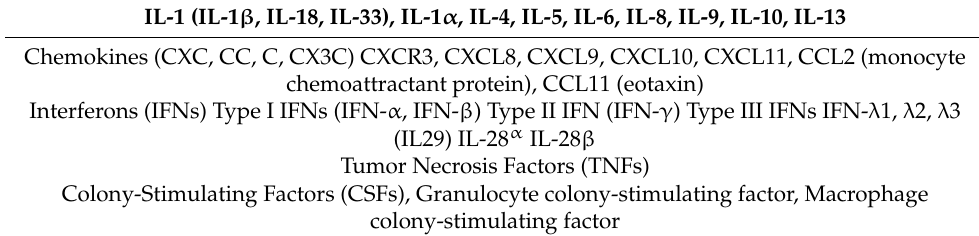
Table 2. Cytokines constituting the cytokine